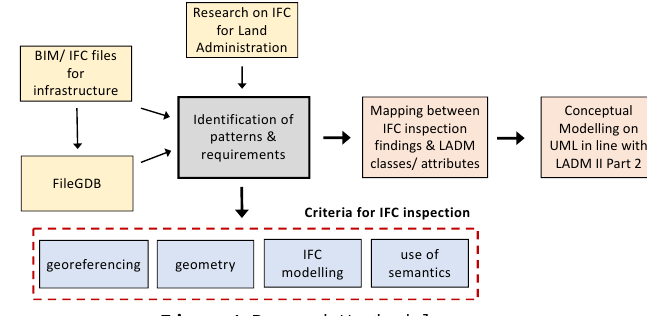
Figure 4 . Research